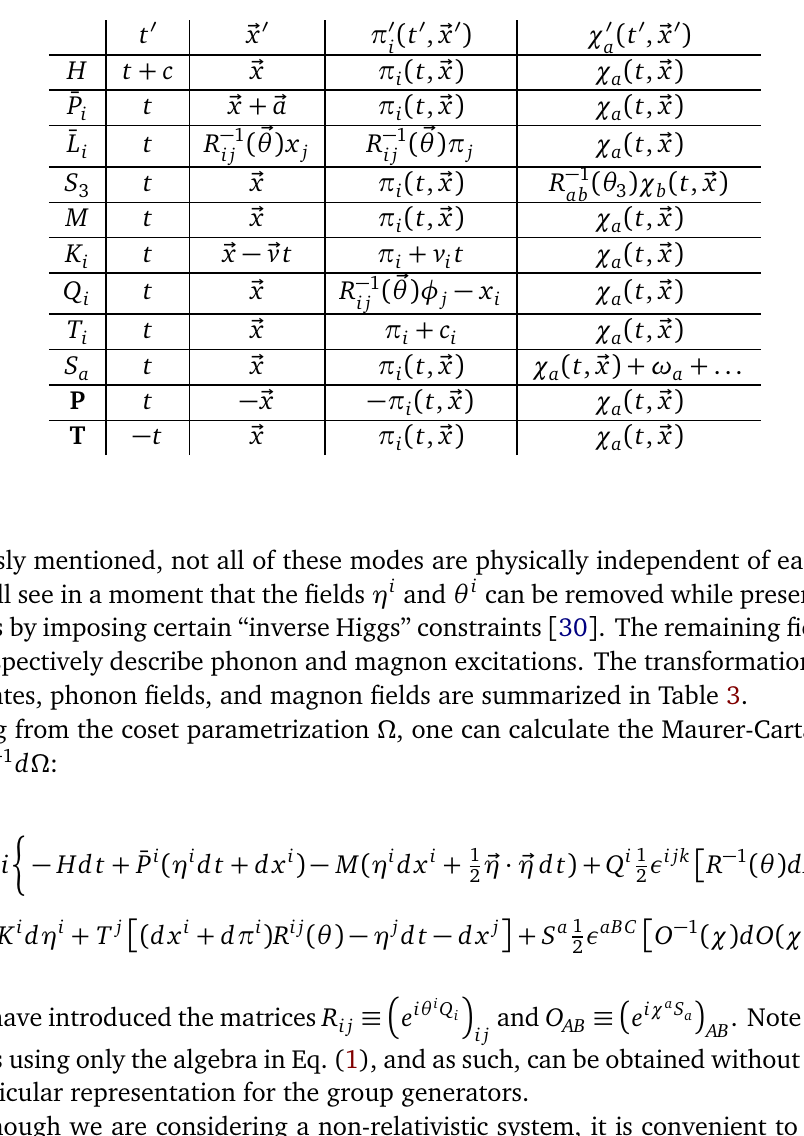
Table 3: Action of the symmetries on the coordinates, the phonon fields π i , and the magnon fields χ a